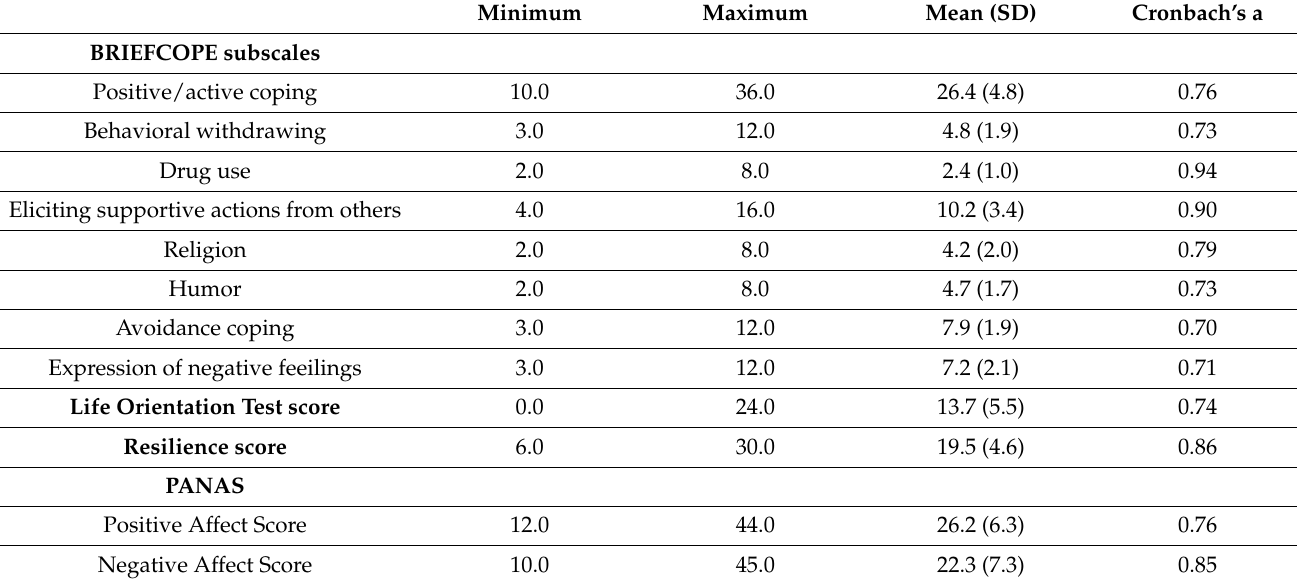
Table 2. Description of BRIEFCOPE, LOT, Resilience and PANAS scales.